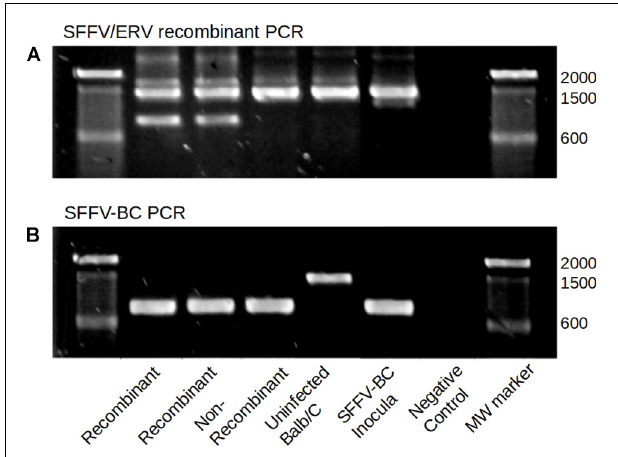
FIGURE 5 | SFFV/ERV recombinant and SFFV-BC specific PCR. (A) Top lanes show products of ERV specific forward and SFFV reverse primers. (B) The bottom lanes show products of SFFV-BC forward and SFFV-BC reverse primers. The expected product size is 850 for both reactions. Higher molecular weight products are likely non-specific amplification of homologous endogenous MuLV sequences due to using one primer with complementary sequences within the mouse genome. The two representative passage lines which showed presence of SFFV/ERV (Recombinants) in deep sequencing reads, also show the expected SFFV/ERV amplicon band, while all samples negative for recombinant by sequencing do not show this amplicon (Non-recombinant, Uninfected BALBb/c, and SFFV-BC